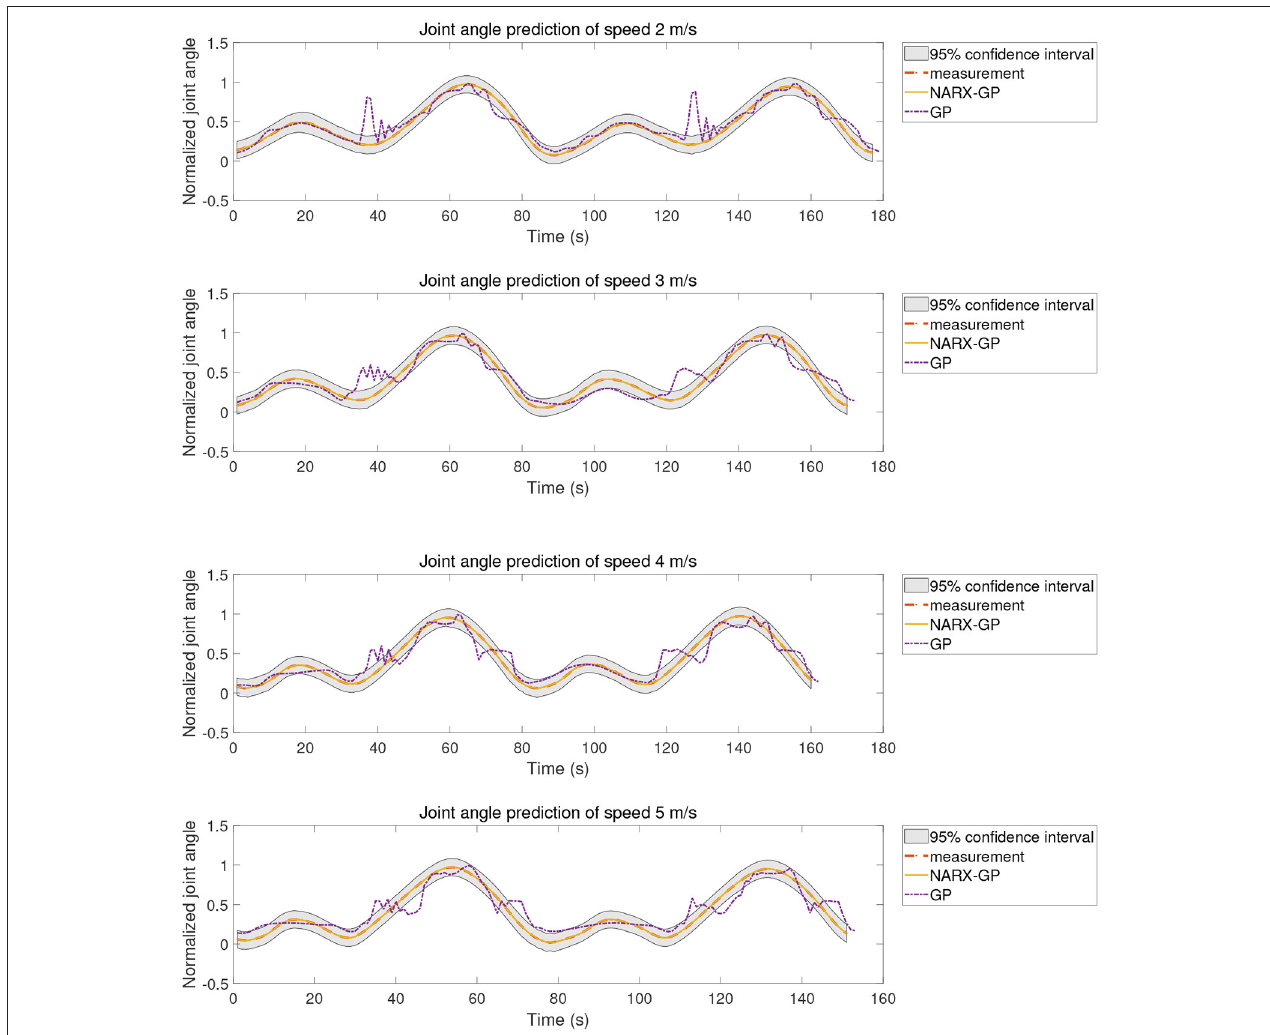
FIGURE 7 | Joint angle prediction under multi-speed of subject